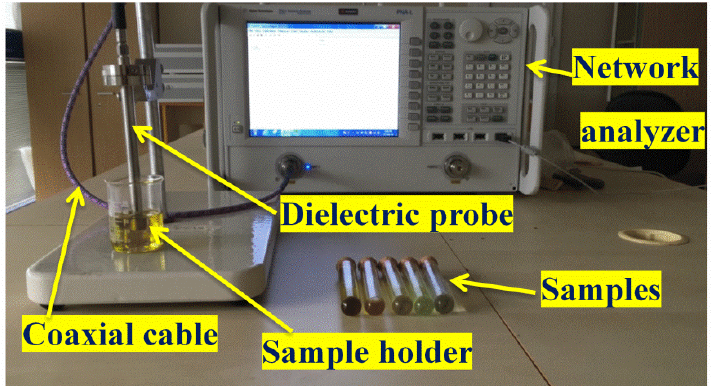
Figure 3. Experimental setup to measure the samples by the 85070E dielectric probe kit.